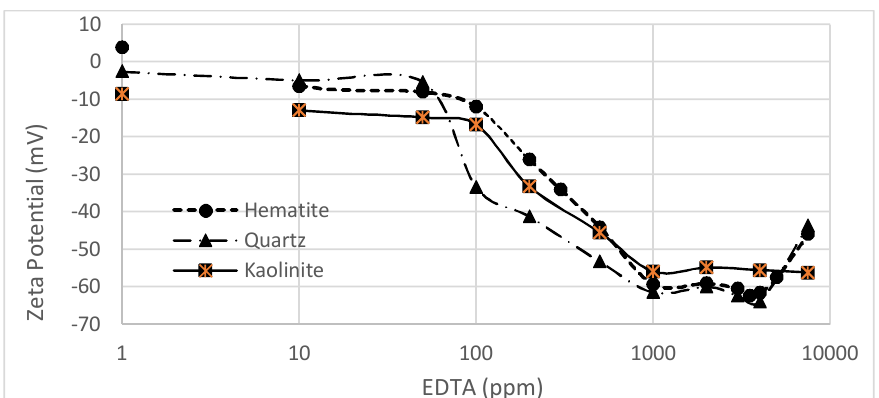
Fig. 8: Effect of EDTA on the ZP of Hematite, Quartz and Kaolinite at 10.5 pH Table 1: Influence of Ligands on the ZP (mV) of Minerals Containing POMI at 10.5